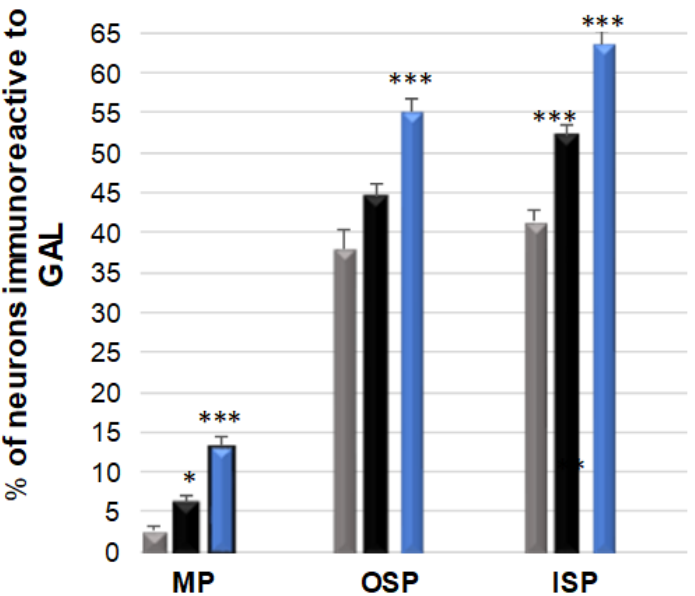
Figure 7. Bar graph showing the percentage variation in the number of galanin (GAL)—immunoreactive neurons as a result of a low (black bar) and a high (blue bar) dose of acrylamide supplementation in the porcine jejunum enteric plexuses. Control pigs (grey bar), MP—the myenteric plexus; OSP—the outer submucosal plexus; ISP—the inner submucosal plexus. * p < 0.01, *** p < 0.001 point to differences in the expression of exact substance studied with reference to the control pigs.